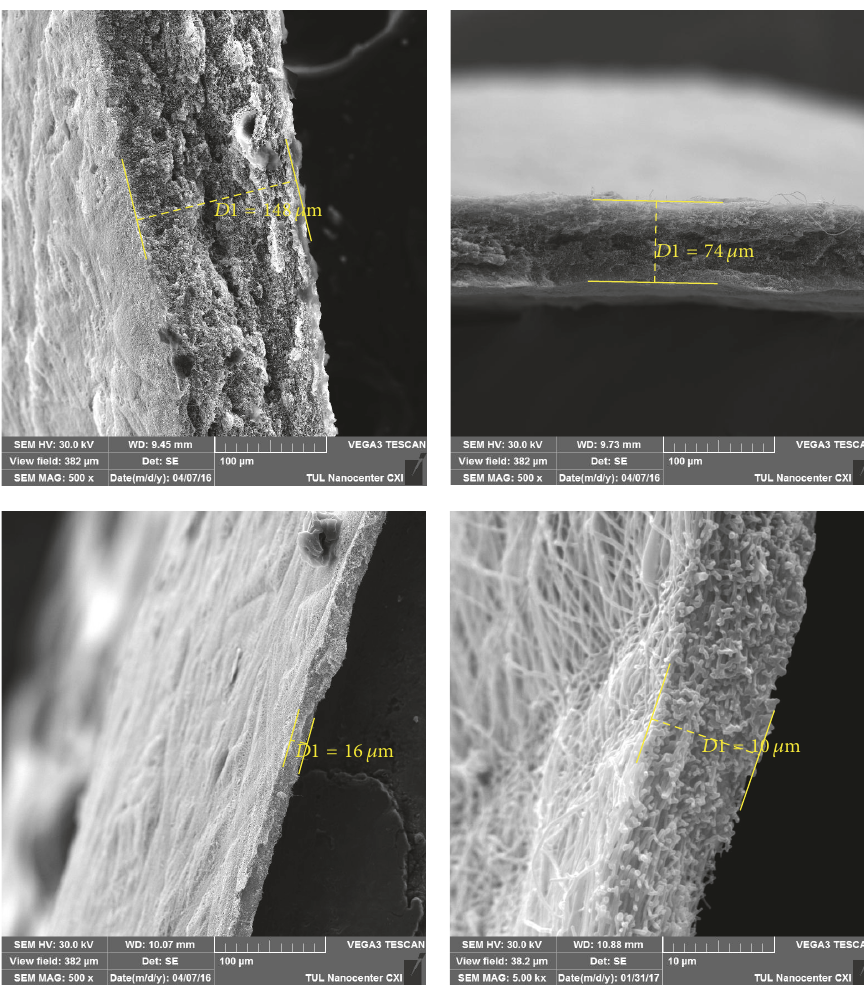
Figure 2: Cross section of membranes: PUR40 (500x), PUR25 (500x), PUR10 (500x), and PUR06